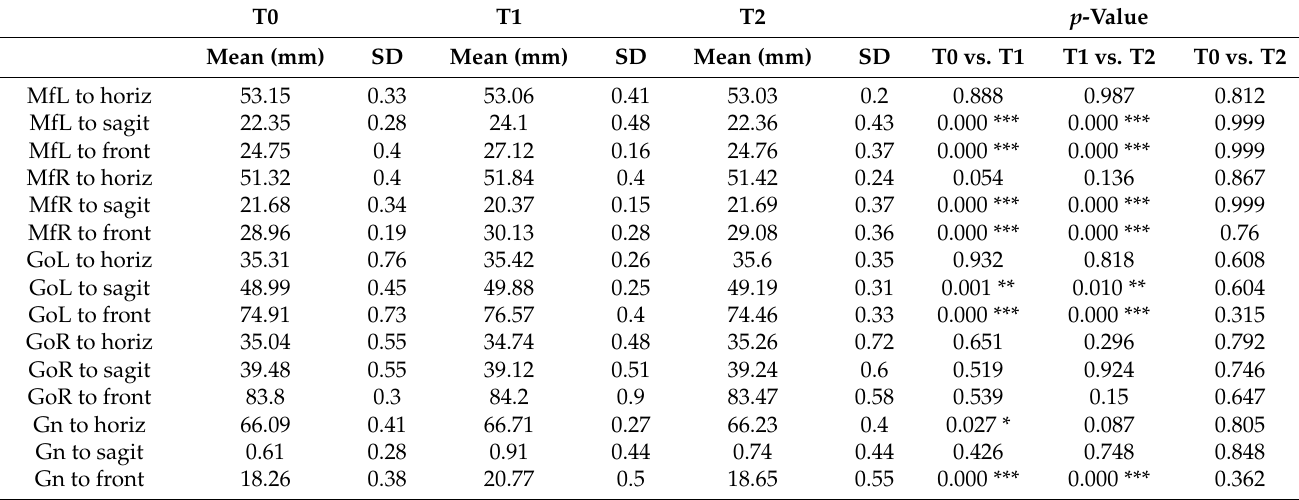
Table 5. The linear changes in mandibular skeletal landmarks at T0, T1 and